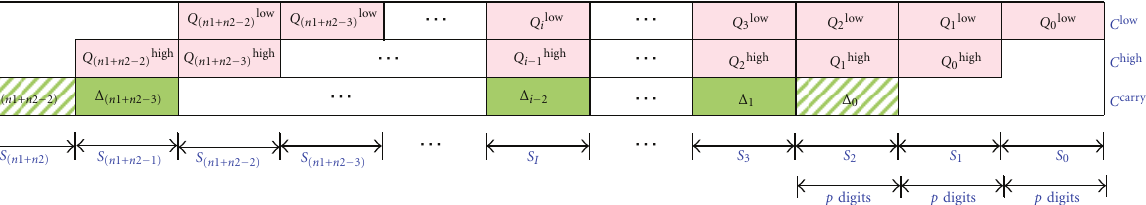
Figure 3: Merging